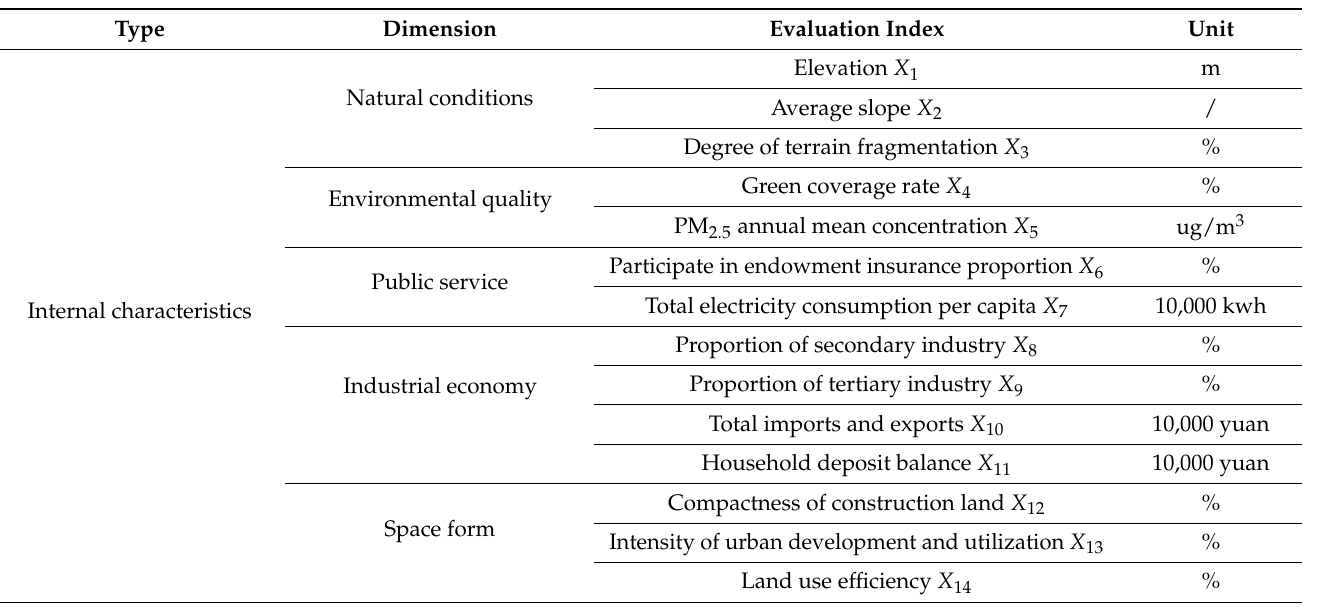
Figure 7. The vitality of each dimension of state-level Urban Agglomerations: ( a ) Exuberant Pop- ularity Index, ( b ) Prosperous Economy Index, ( c ) Multivariate Functions Index, and ( d ) Urban Vitality Index. Table 5. Index system of influencing factors of urban